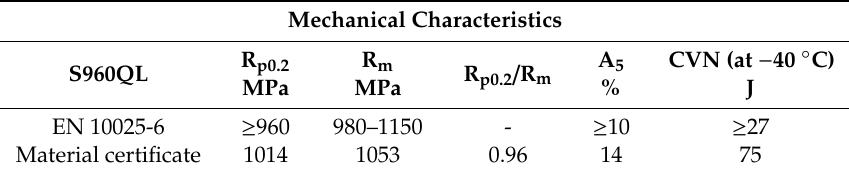
Table 2. Mechanical characteristics of the investigated S960QL